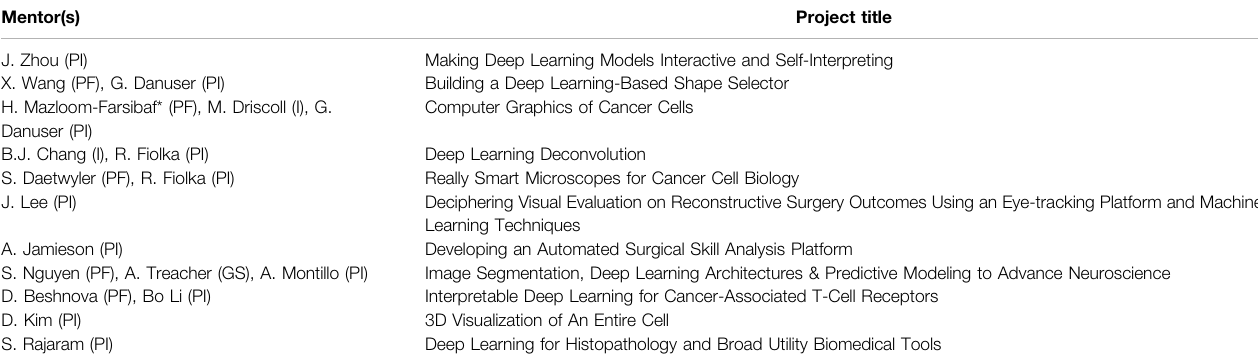
TABLE 1 | Overview about selected projects. Graduate Student (GS), Postdoctoral Fellow (PF), Instructor (I), Principal Investigator (PI). * Biweekly lab meeting coordinator.